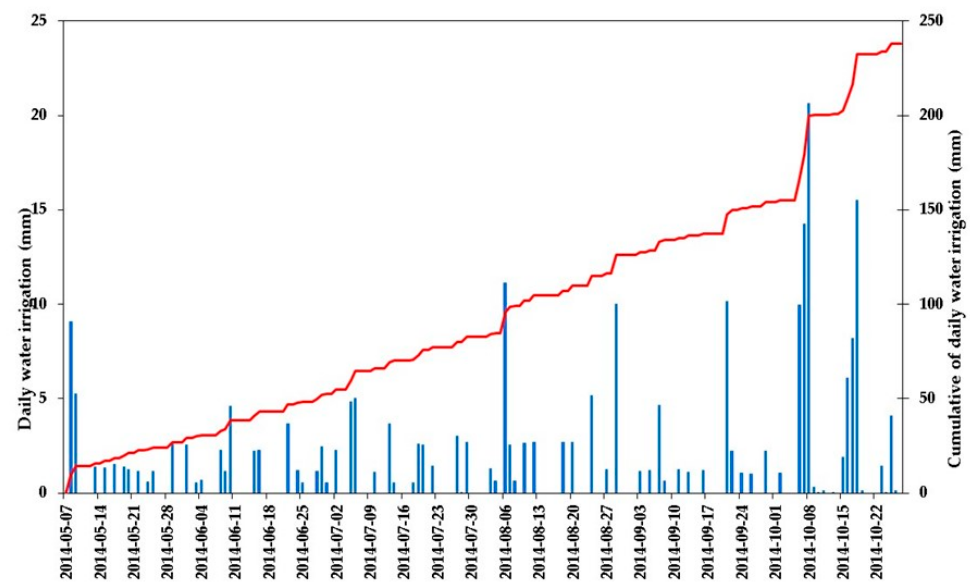
Figure 4. Frequencies and quantities of water used during daily irrigation (in blue), as well as the evolution of cumulative daily irrigation (in red) during the production of white spruce seedlings.